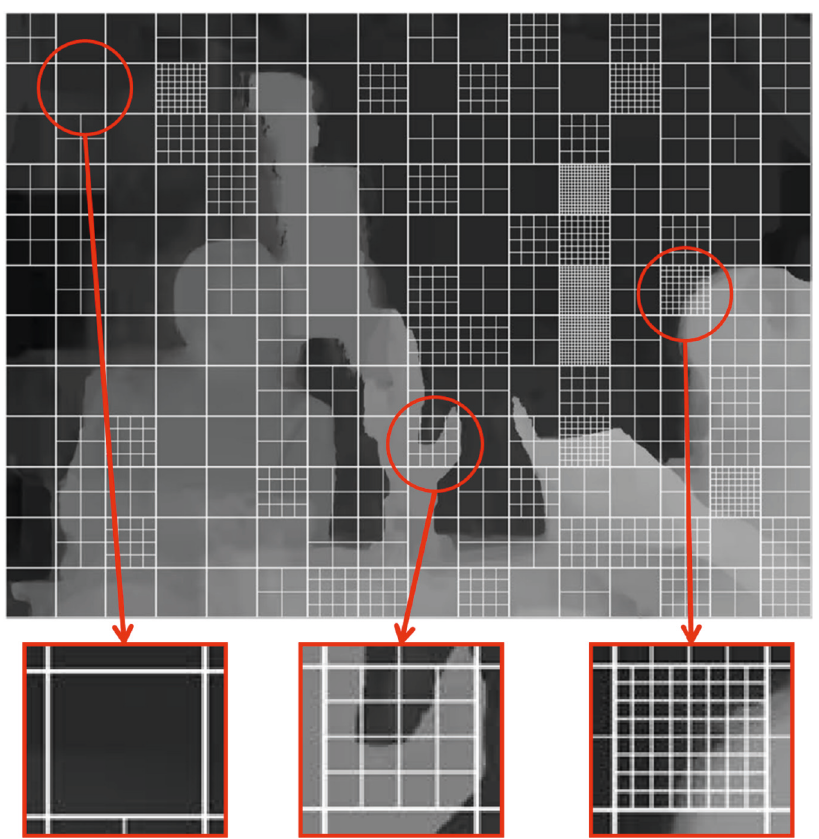
Figure 4: The relationship between the CTU and its complexity